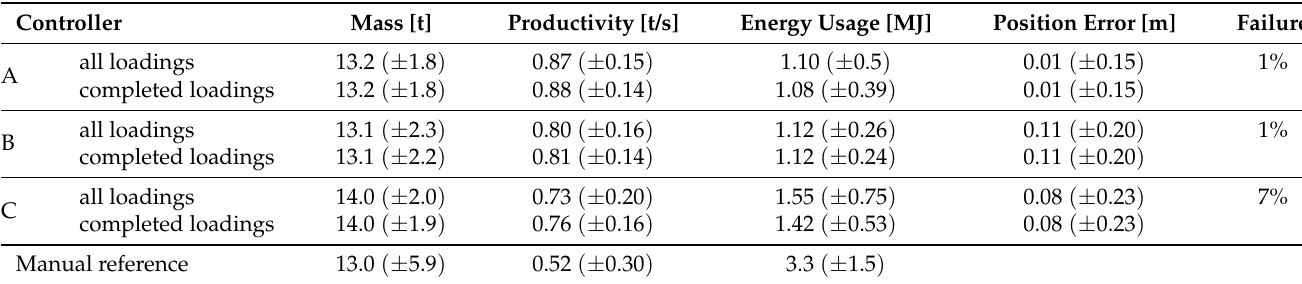
Figure 7. Boxplot of the loaded mass during repeated mucking when using controller A. The whiskers show the maximum and minimum values. Table 1. Mean performance for the three DRL controllers and manual loading performance [13] (re-scaled from ST14 to ST18 for